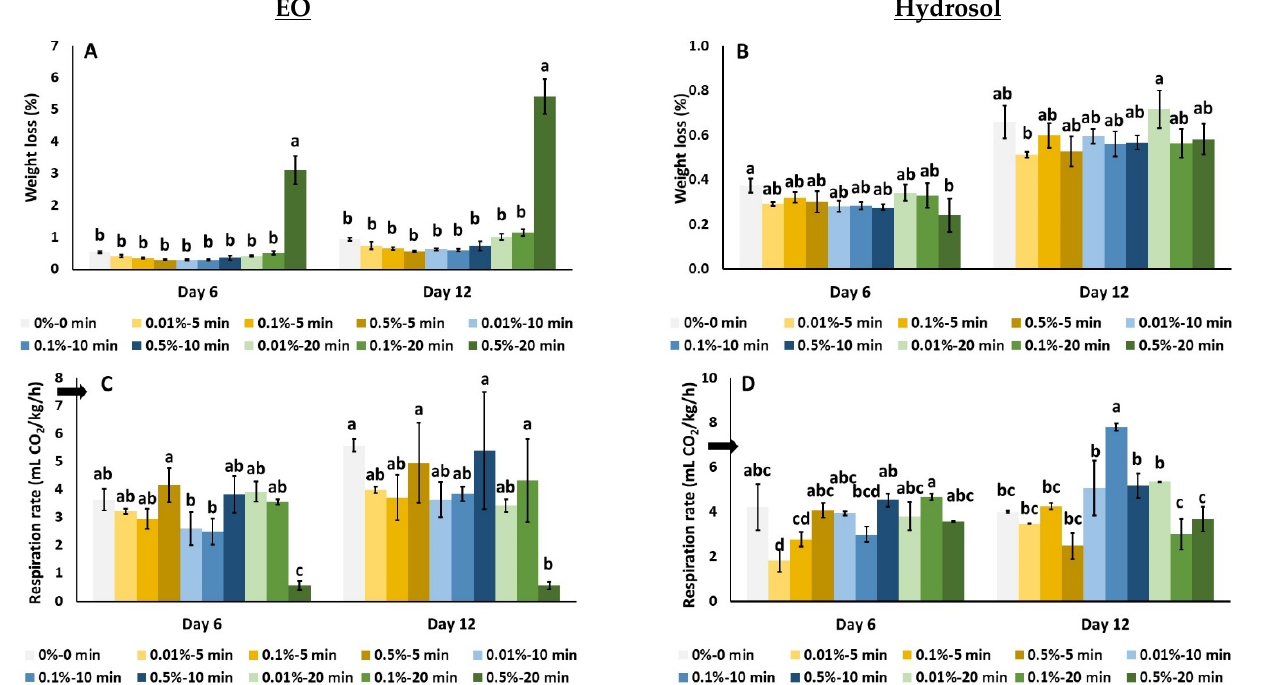
Figure 1. Screening of O. dubium EO ( A , C ) and hydrosol ( B , D ) application effects on weight loss and respiration rate of tomato fruit stored at 11 °C for 12 days. Bars represent the mean ± standard error of four biological replicates per treatment. Measurements for day 0 refer to the control and are indi- cated with an arrow. On each day, significant differences ( p < 0.05) among treatments are indicated with different Latin letters.